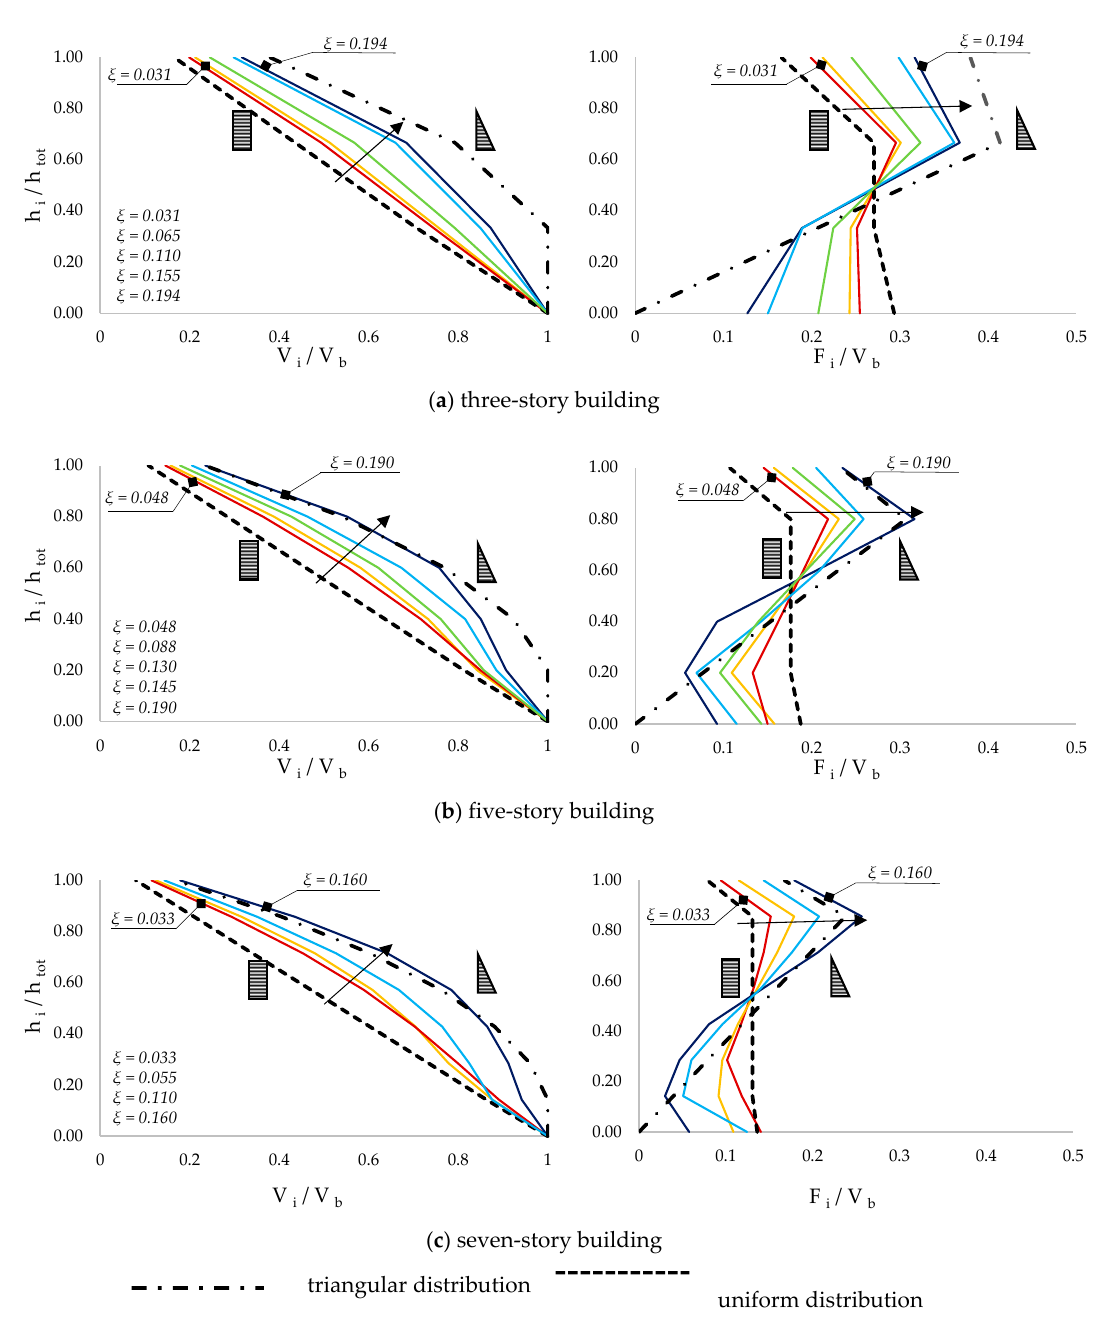
Figure 7. Story shear envelopes ( left ) and lateral force distributions ( right ) obtained from the NLTH analysis compared with the equivalent distribution employed for the linear static analysis (LSA) (uniform and inverted triangular).